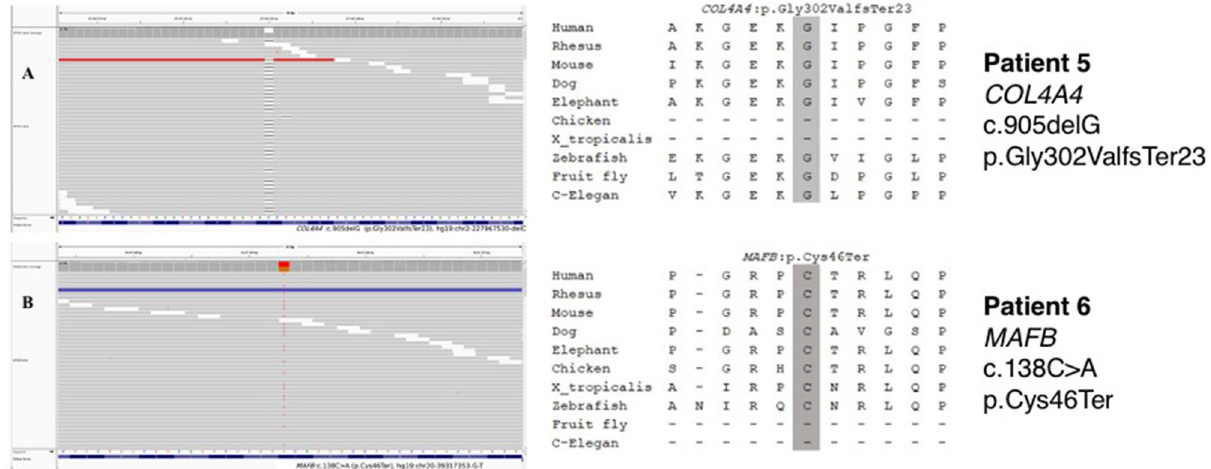
Figure 2. Screenshots of WES alignments of three novel variants and sequence alignment of partial amino acid sequences of COL4A4 ( A ) and MAFB ( B ) from various